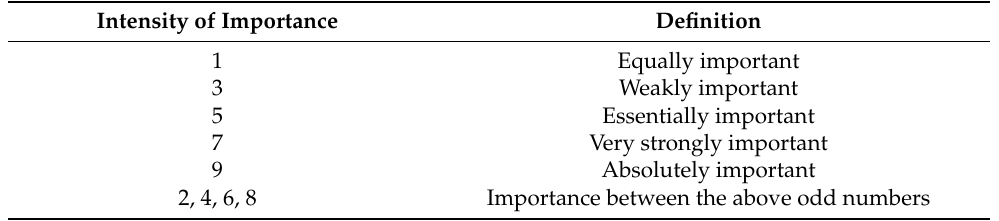
Figure 6. Hierarchy structure of AHP. Table 3. Evaluation criterion of